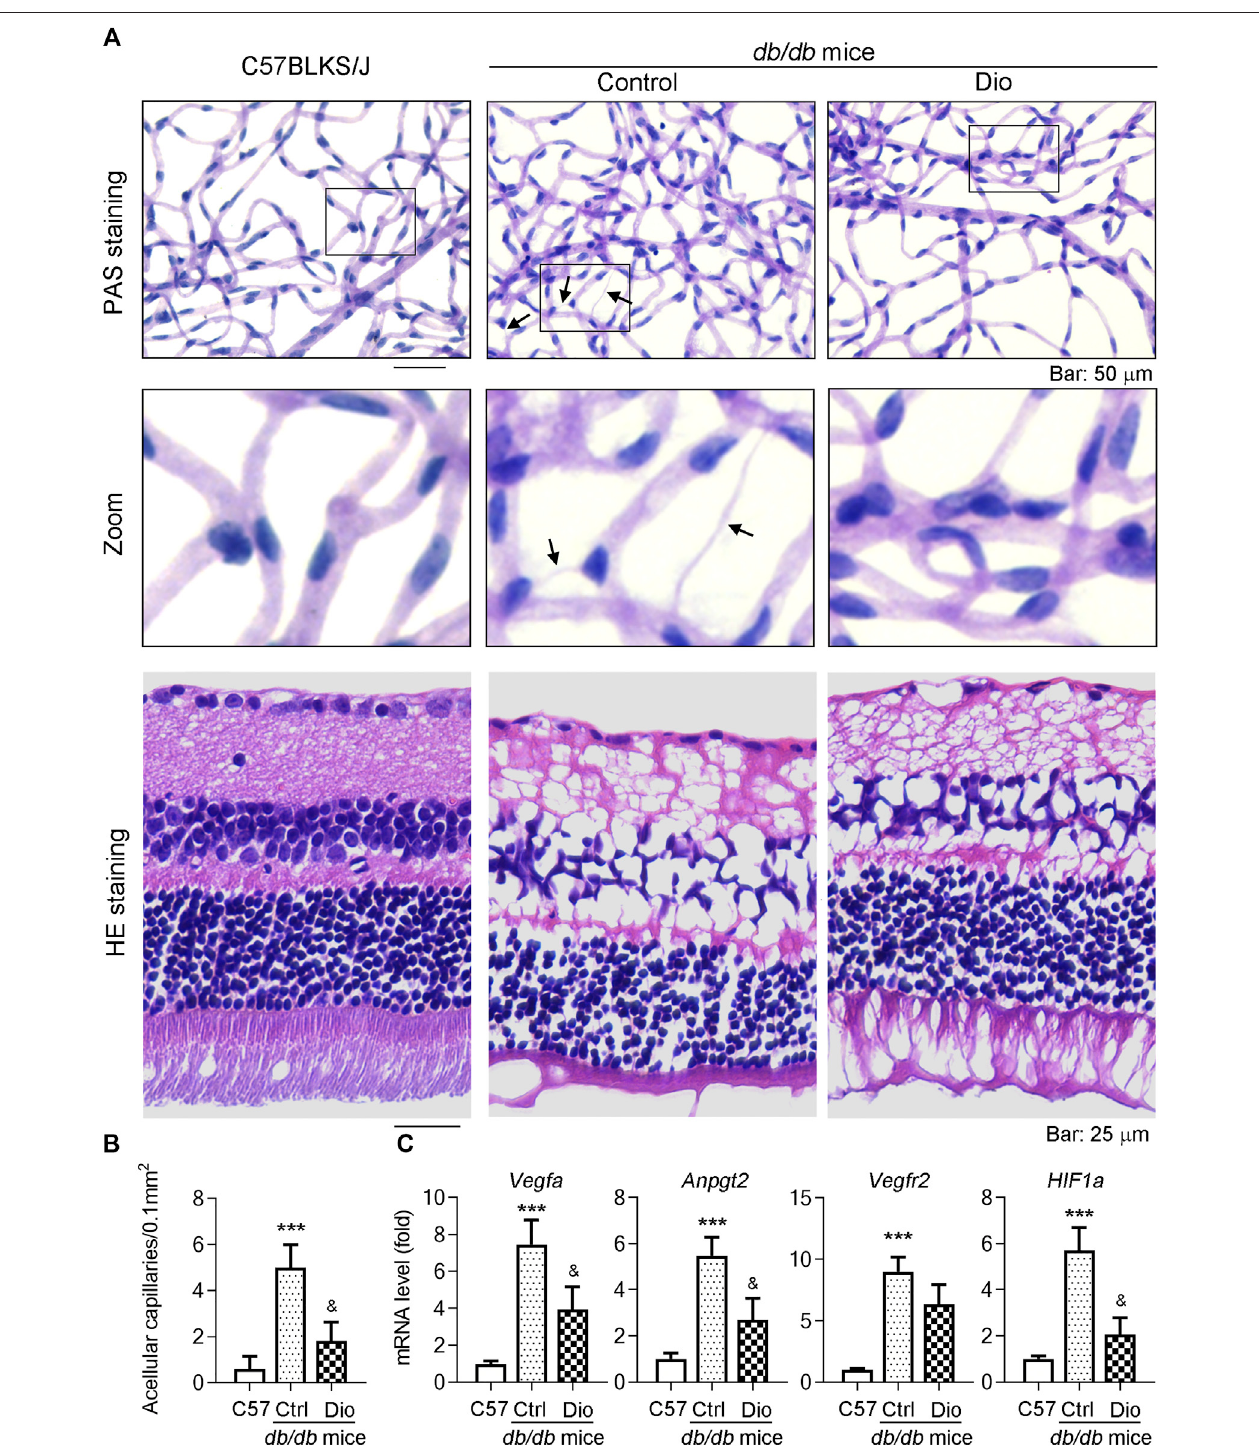
FIGURE 5 | Ocular delivery of dioscin ameliorates vascular damage in the retina of db/db mice. (A) At the end of the study, mouse eyes were collected and the retinalvascularnetworkwasprepared,followedbyPASandHandEstaining.Therepresentativeimagesfromeachgrouparepresented.Blackarrowsindicateacellular capillariesintheretinalvasculature.Bars:50 μ m. (B) Quantitationofacellularcapillariesintheretina. (C) Vegfa , Vegfr2,Angpt2, and Hif1 α mRNAexpressionintheretinas was determined by qPCR analysis, n (cid:1) 5. *** p < 0.001 vs. C57BLKS/J mice and & p < 0.05 vs. db/db mice by one-way ANOVA with Bonferroni correction.